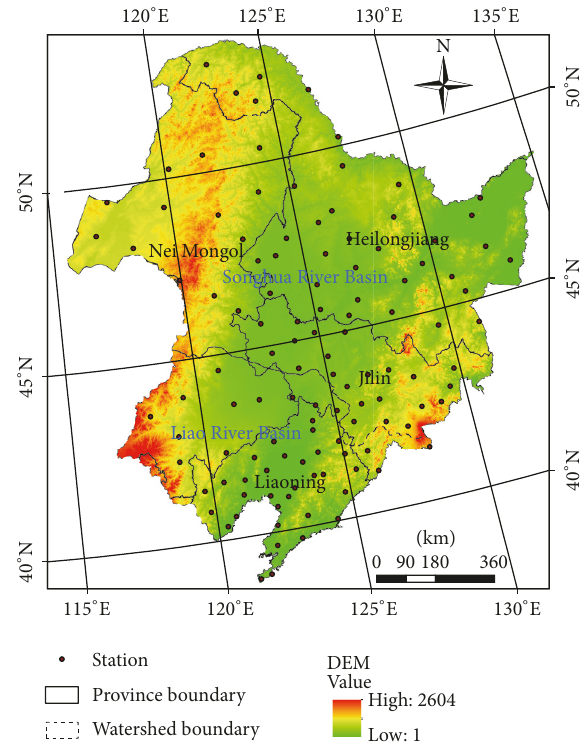
Figure 1: The geological location of SLRB and Digital Elevation Model